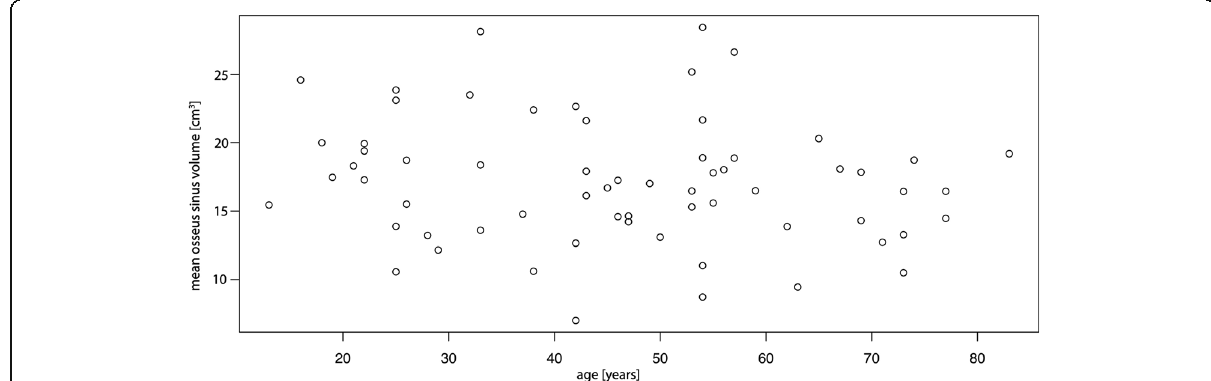
Fig. 7 The association between the mean osseus sinus volume and age. No significant association between these parameters was found ( p =